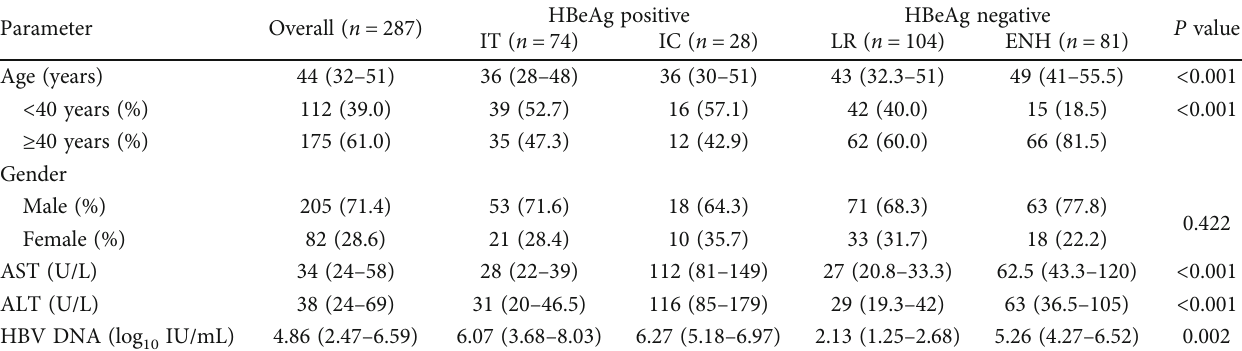
Table 1: Characteristics of study populations.